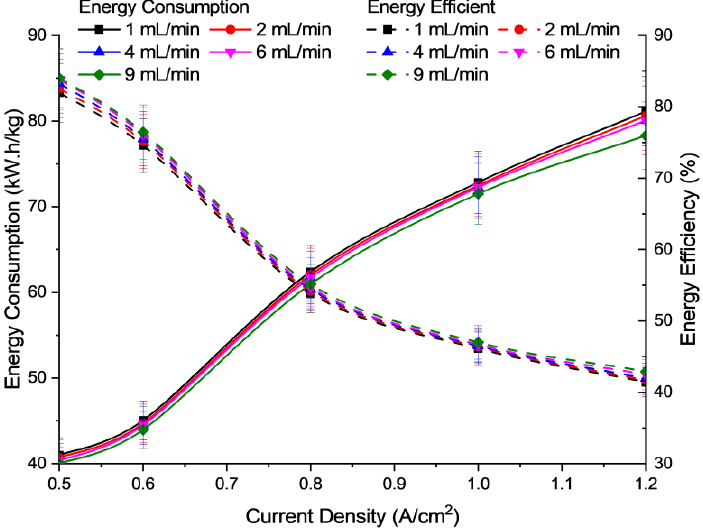
Figure 10. Profile of energy consumption and energy efficiency of electrolysis for different electrolyte flow rate at 30 °C operational temperature and concentration of electrolyte 2.0 M KOH.